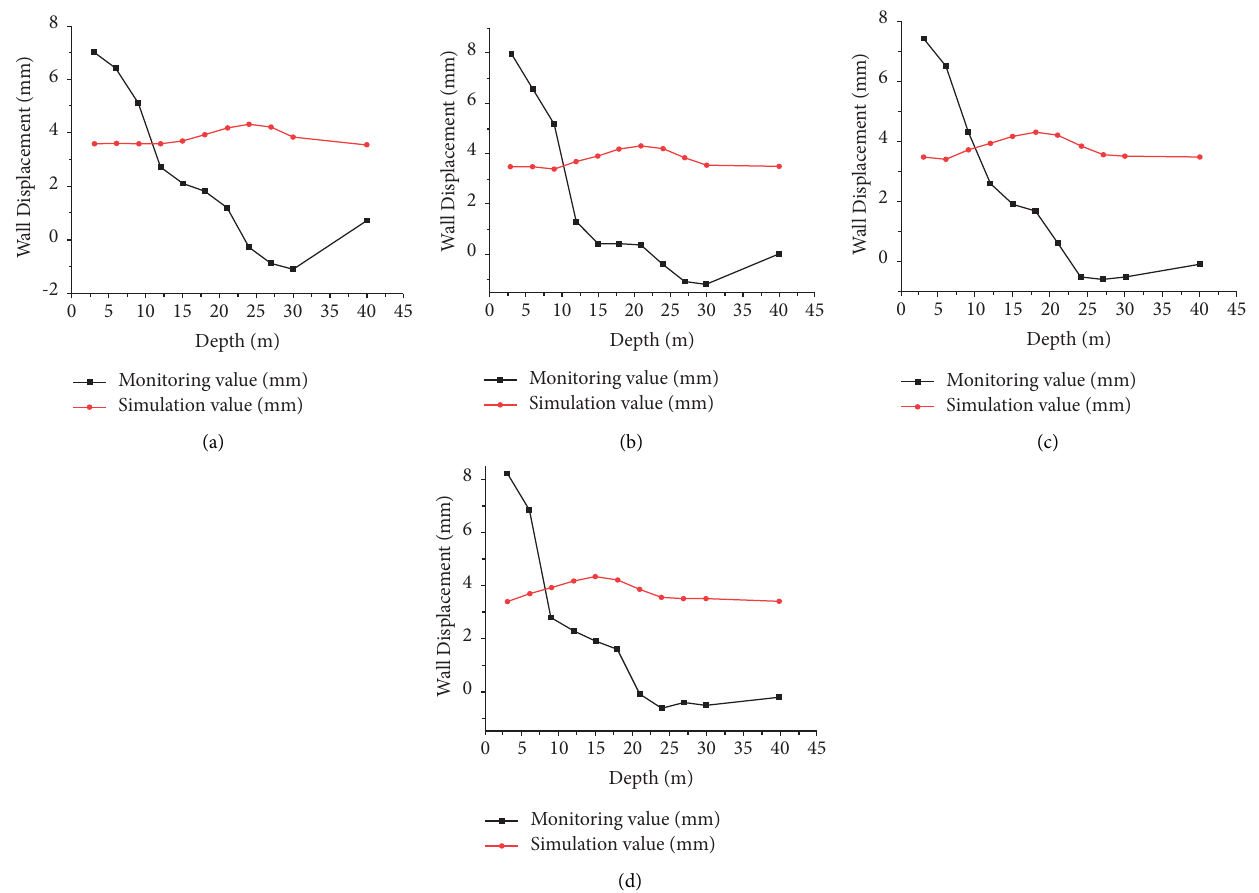
Figure 9: Parameter verifcation of working condition 6. (a) No. 2 section ( P � 0.0793). (b) No.15 section ( P � 0.05399). (c) No. 28 section ( P � 0.066897). (d) No. 42 section ( P �